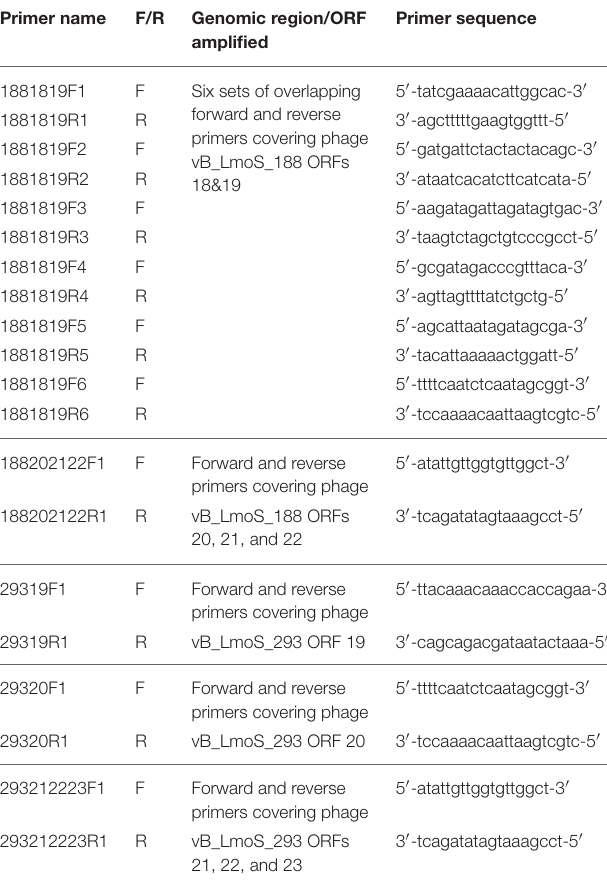
TABLE 2 | Primers sequences designed for DNA amplification of the late tail genes in phages 188_Mut and